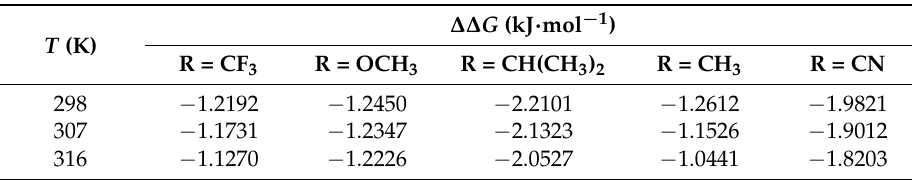
Table 7. Values of ∆∆ G at the relevant